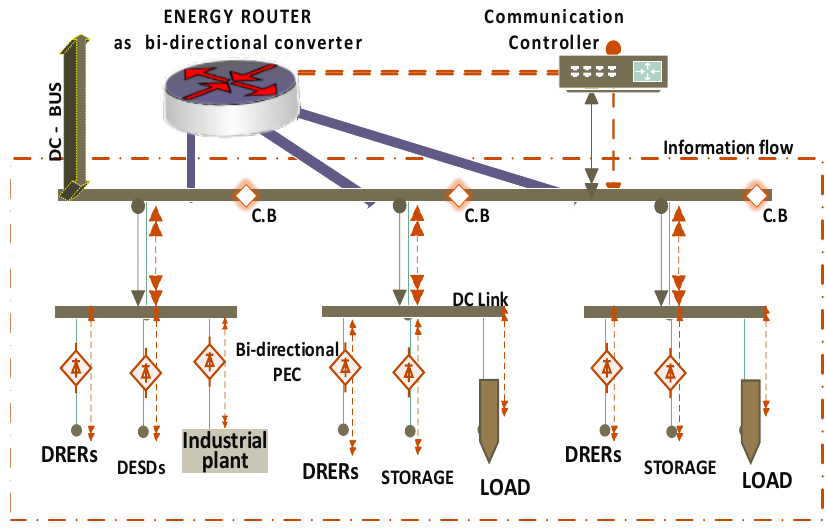
Figure 6. Multiport converter (MPC)-based E-router model.